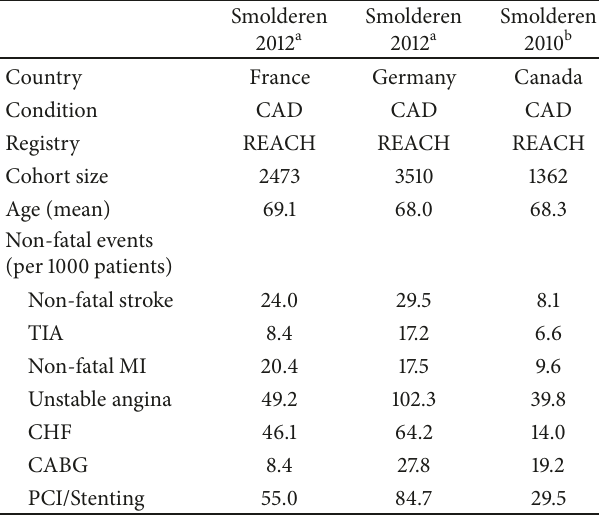
Table 1: Clinical burden of